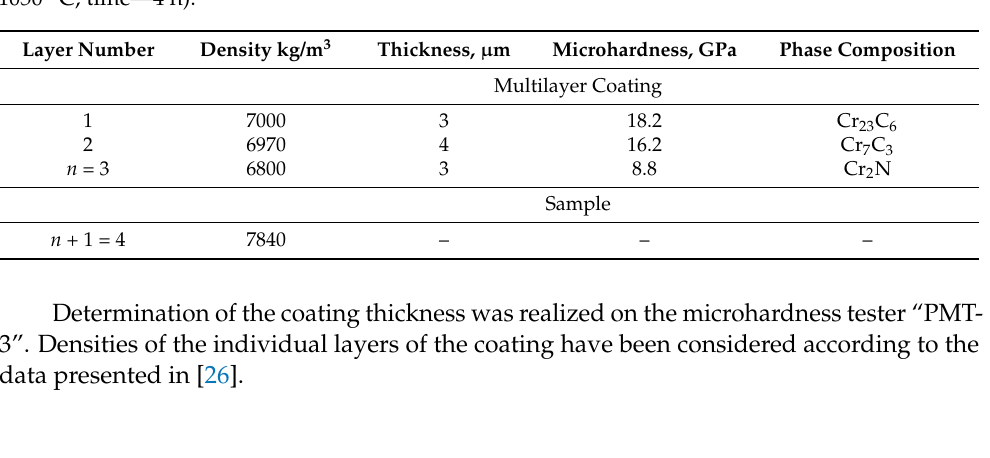
Table 1. Density, thickness, microhardness, and phase composition of the protective coating layers after nitrogenchroming: nitriding (temperature—540 ◦ C, time—36 h) and chroming (temperature— 1050 ◦ C, time—4